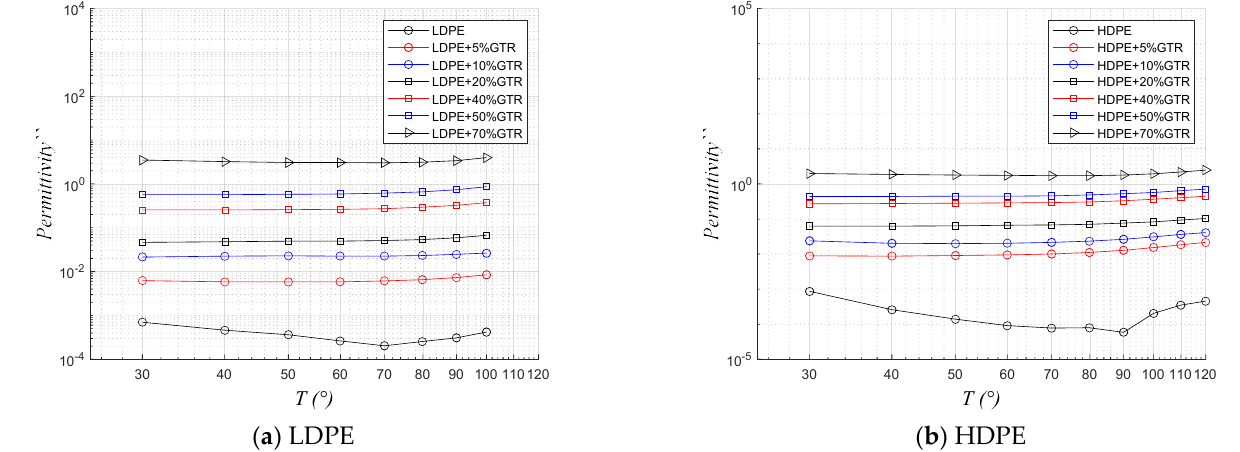
Figure 8. Thermal response of imaginary permittivity ( ԑ ”) with a temperature range of 30 to 100 °C, at 50 Hz, of ( a ) LDPE/GTR compounds and ( b ) HDPE/GTR compounds.